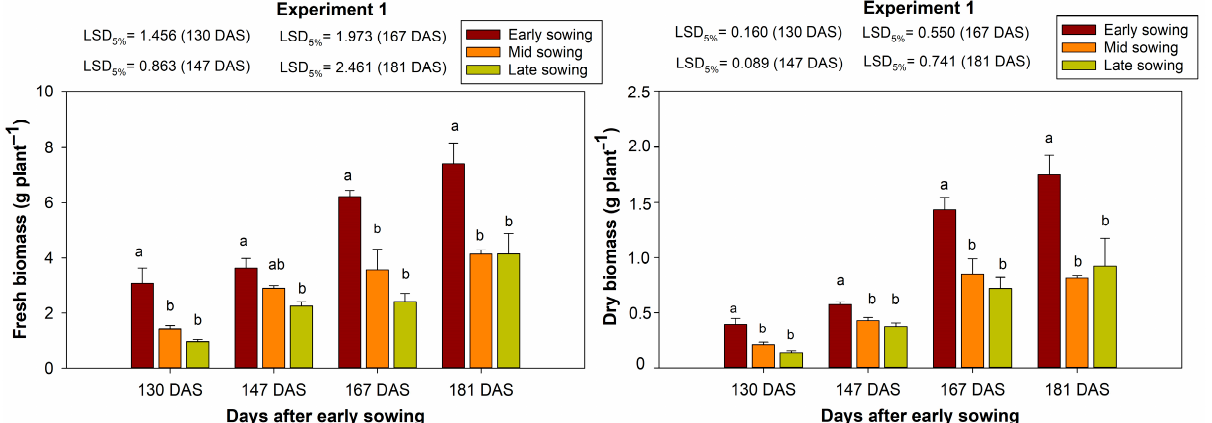
Figure 4. Fresh and dry biomass (g plant − 1 ) of bristly oxtongue as affected by the sowing date (early, mid, and late). For each sampling date, bars followed by the same letters were not shown to significantly differ with Fisher’s least significant difference (LSD) test. Errors bars show the Standard Error values. Final measurement (source of variation: treatments): Fresh biomass: Fvalue = 9.105, p = 0.032, DF (degrees of freedom) = 2 and Dry biomass: Fvalue = 7.382, p = 0.045, DF =